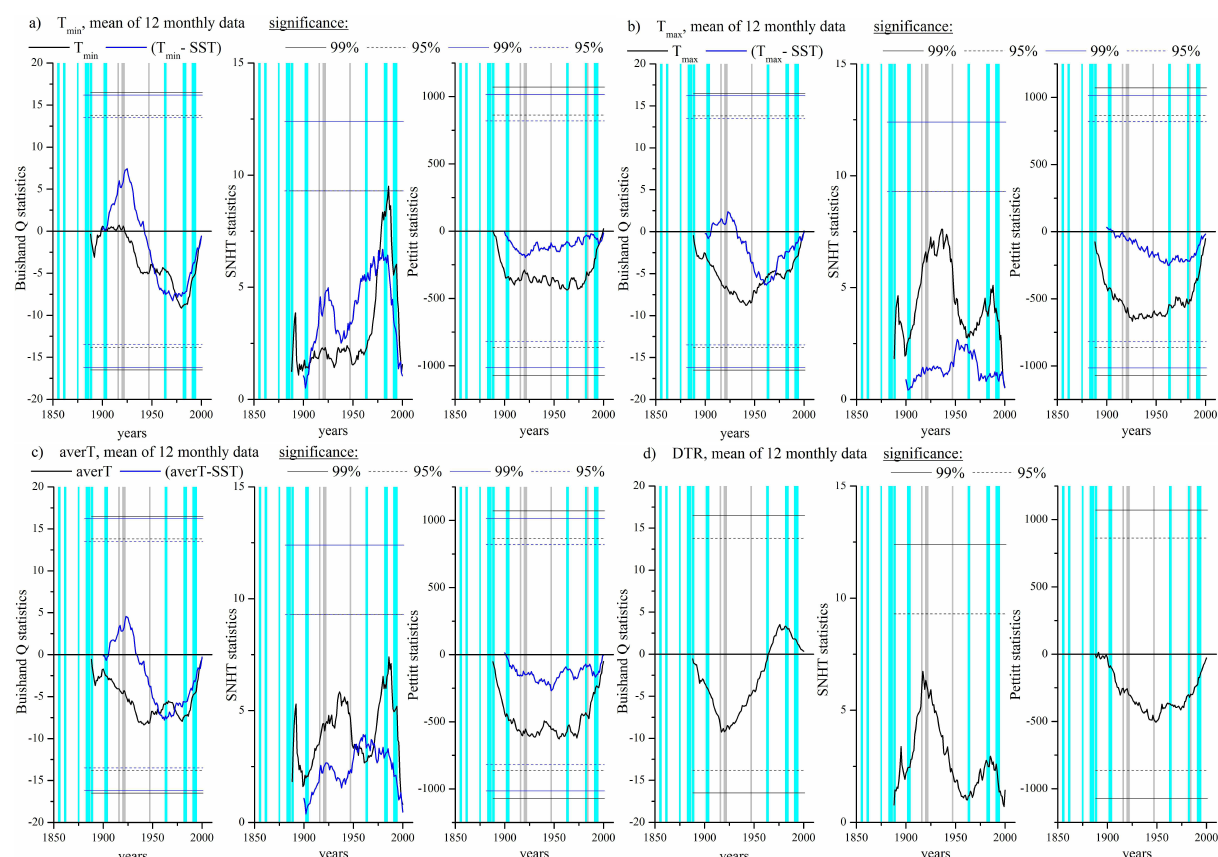
Figure 9. Porto: same as Fig. 5a–d but for the corrected series.